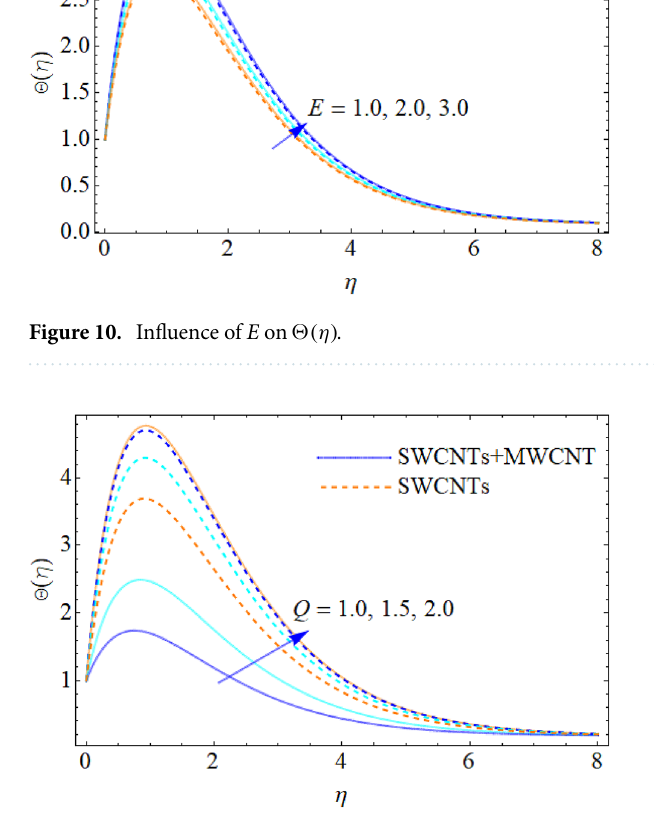
Figure 11. Impact of Q on �(η) .